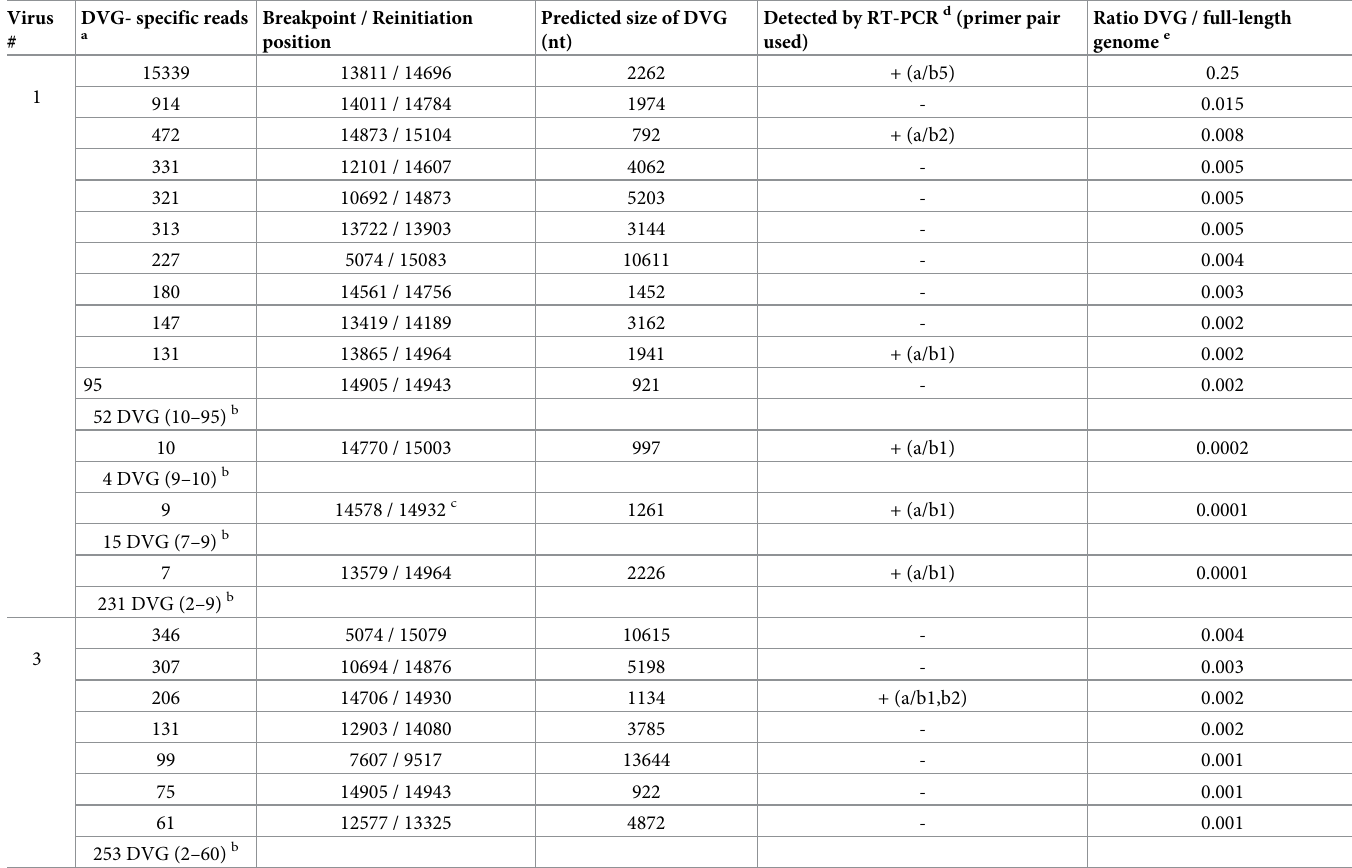
Table 3. 5’ copyback DVGs identified in viruses #1 and #3 using DVG- profiler. Virus DVG- specific reads #